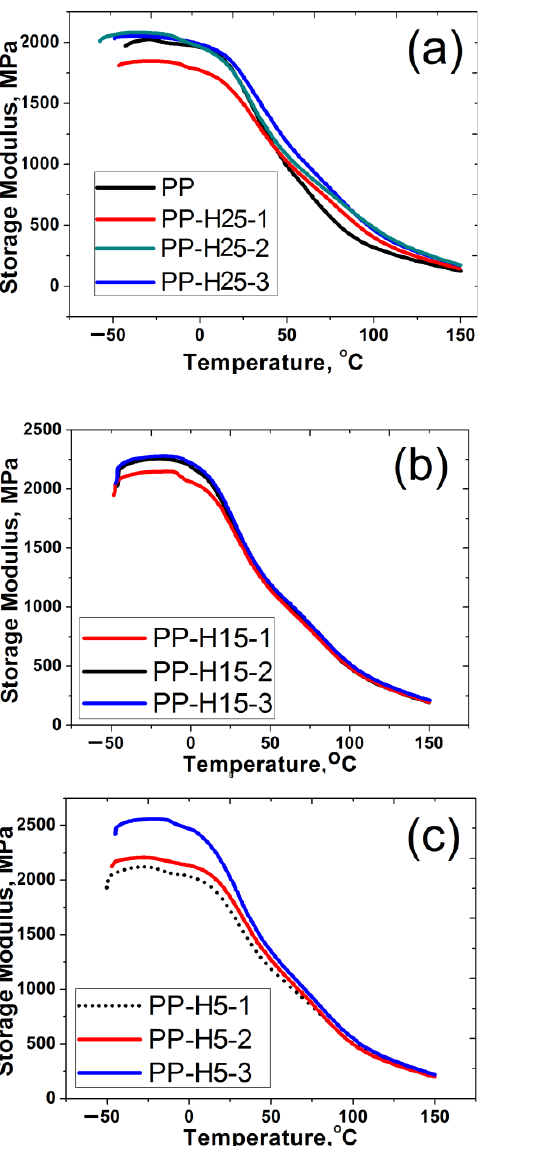
Figure 13. DMA results of the test samples, ( a – c ) storage modulus and ( d – f ) tan δ.